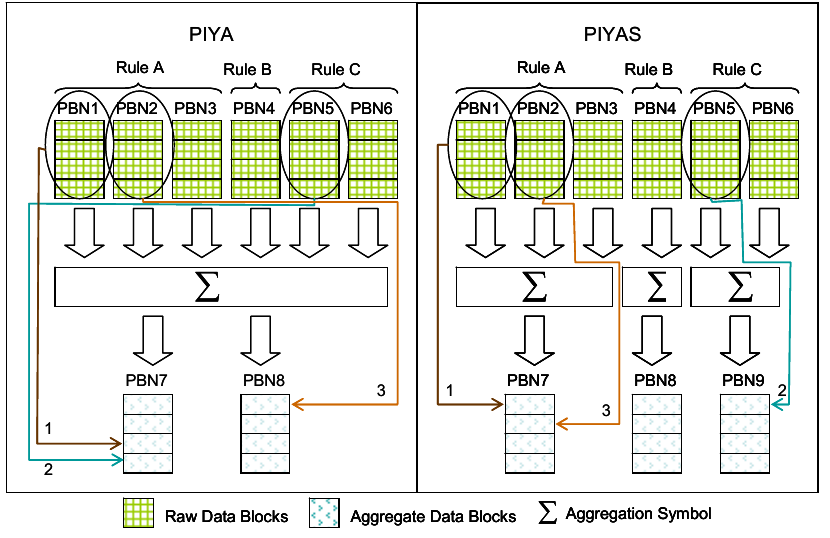
Figure 4. Flash memory block